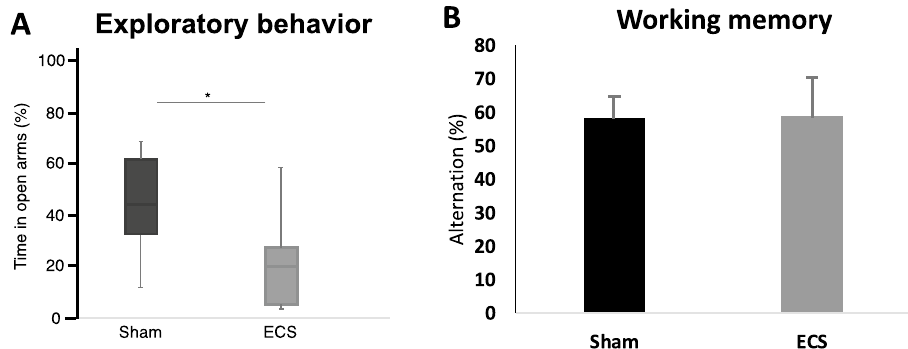
Figure 4. The effect of ECS on behavioural outcome. ( A ) Exploratory behaviour measured in Elevated Plus Maze. Box plots represent the median values for each group with interquartile ranges and error bars indicating the minimum and maximum. ( B ) Working memory measured as spontaneous alternation in Y-maze after 5 weeks. Bars represent mean values with error bars displaying SD * represents p ≤ 0.05 in Mann–Whitney U-test. For sham n = 7 and 6, for ECS n = 9 and 10 for Elevated plus maze and Y-maze